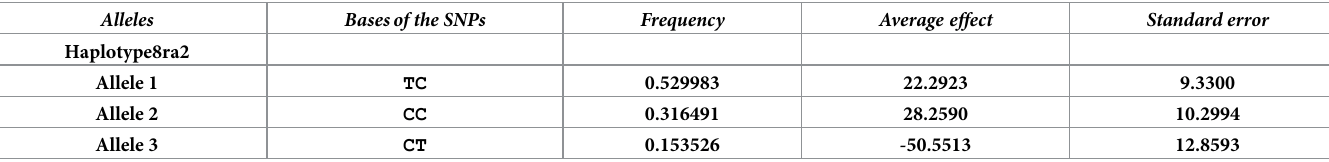
Table 2. Frequency, average effect, and respective standard error of haplotype alleles located in the PAPP-A gene. Alleles Basesof the